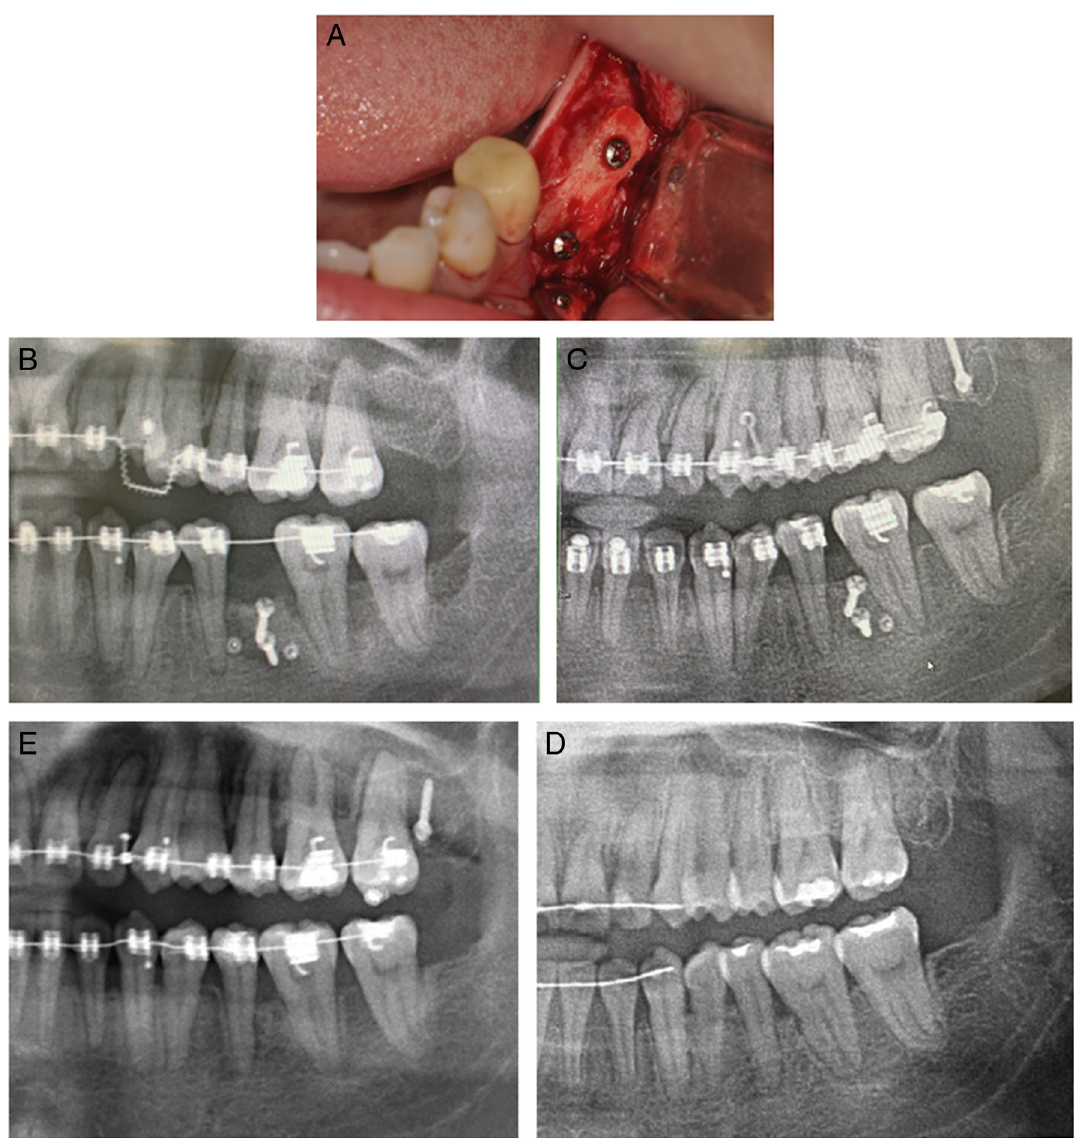
Figure 5. Case 2: (A) The image shows the bone block temporarily fixed with tenting screws for stabilisation (Image shown here was from a similar intra-operative view to our patient’s surgical procedure, courtesy of Dr. Chou). (B–E) Sequential panoramic radiographs of the lower left molars after GBR